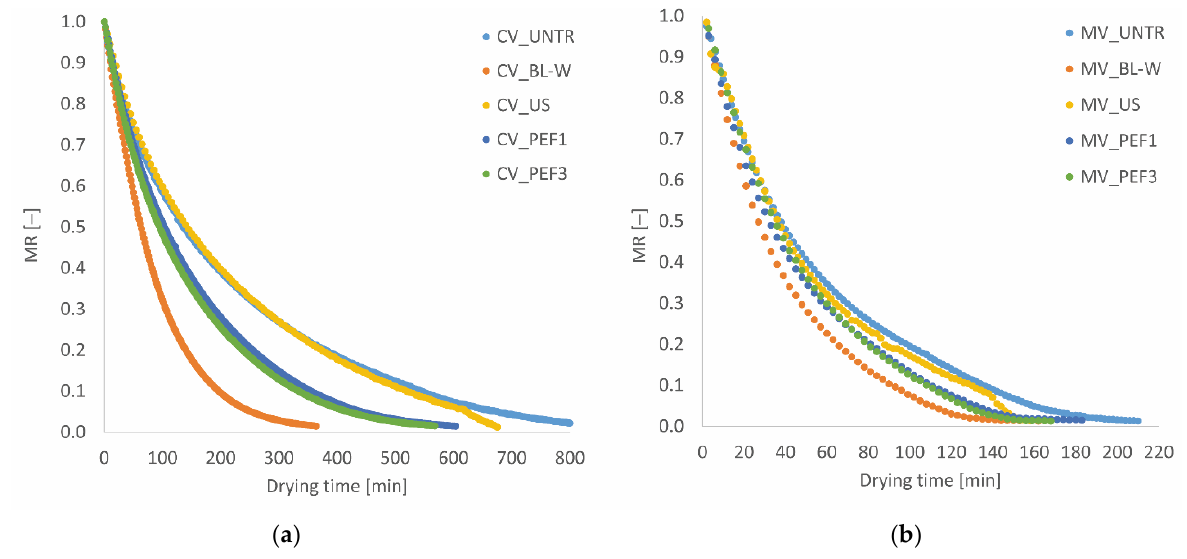
Figure 1. Drying kinetics for ( a ) convective (CV) and ( b ) microwave – convective (MV) dried red bell pepper without and with subjected thermal or non-thermal treatment prior to drying.